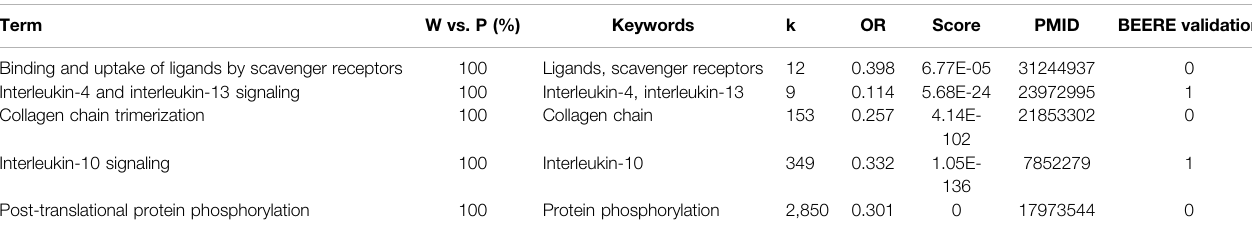
TABLE 4 | The 5 consensus pathways between PAGER, WebGestaltR results with PubMed literature support. Term W vs. P